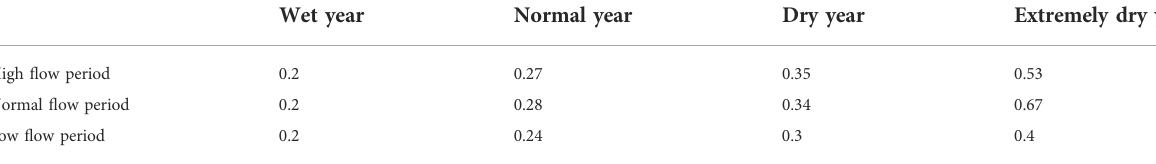
TABLE 3 Reduction coef fi cient ( μ ) in different typical